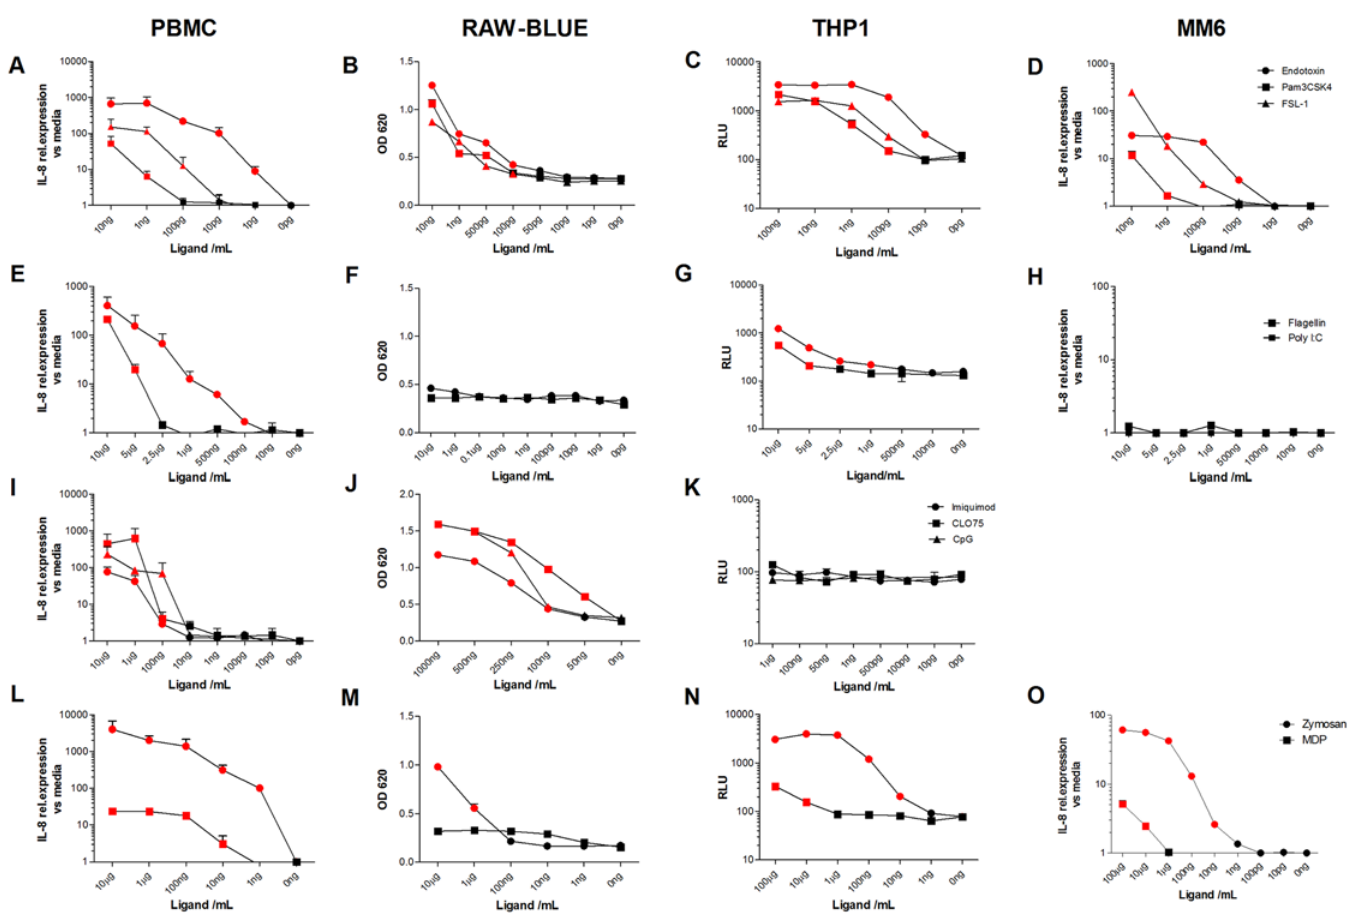
Fig 3. Limit of detection to PRR ligands in PBMC and monocyte/macrophage cell lines. PBMC, RAW-BLUE, THP-1 and MM6 cells were stimulated with the indicated concentration of ( A-D ) Endotoxin, Pam3CSK4 and FSL-1, ( E-H ) Poly I:C and Flagellin, ( I-K ) Imiquimod, CLO75 and CpG ( L-O ) zymosan and MDP. Levels of IL-8 mRNA (relative expression vs media), NF- κ B activation (OD 620) and luciferase activity (RLU) were measured as described in materials and methods. All samples were tested in triplicate. Data points represent mean ± SD. ( * p < 0.05 vs media control). Red points show the limit of detection for each individual IIRMIs.